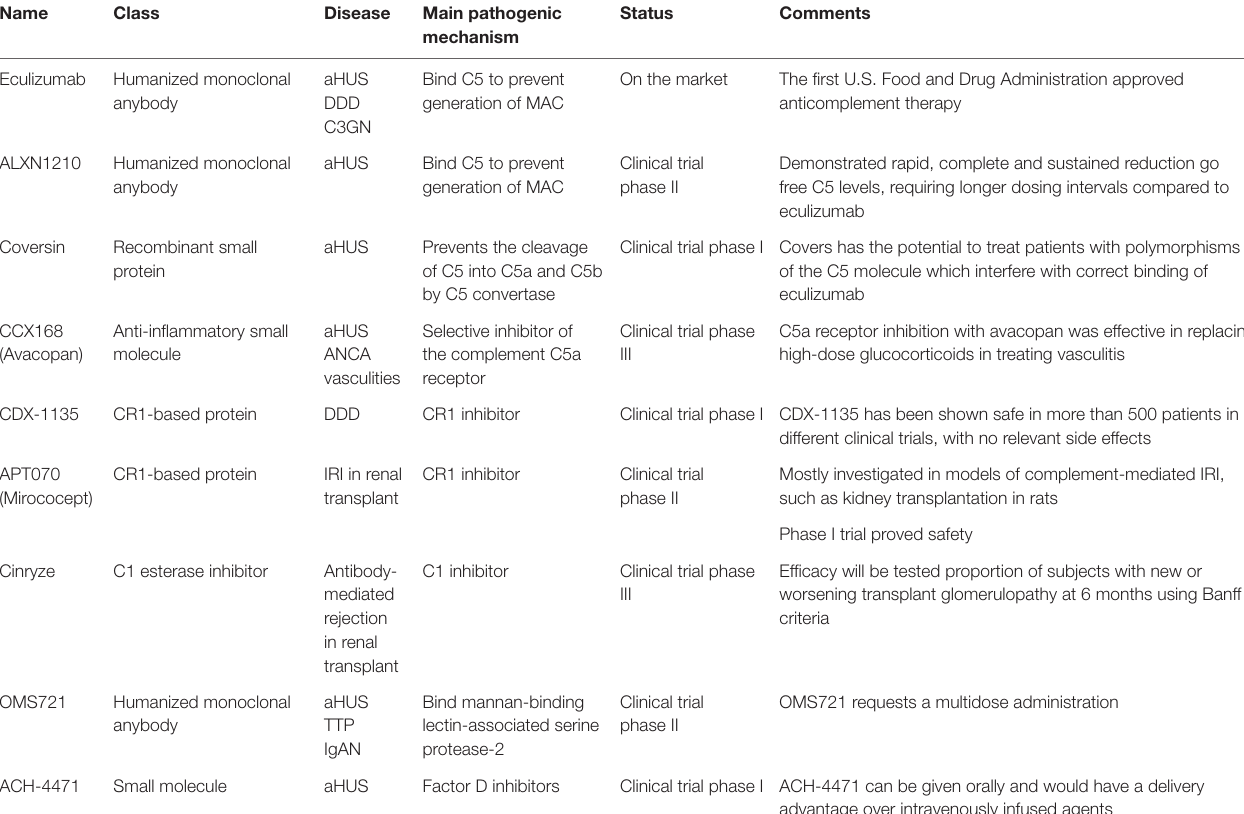
TAbLe 2 | Main complement-targeting